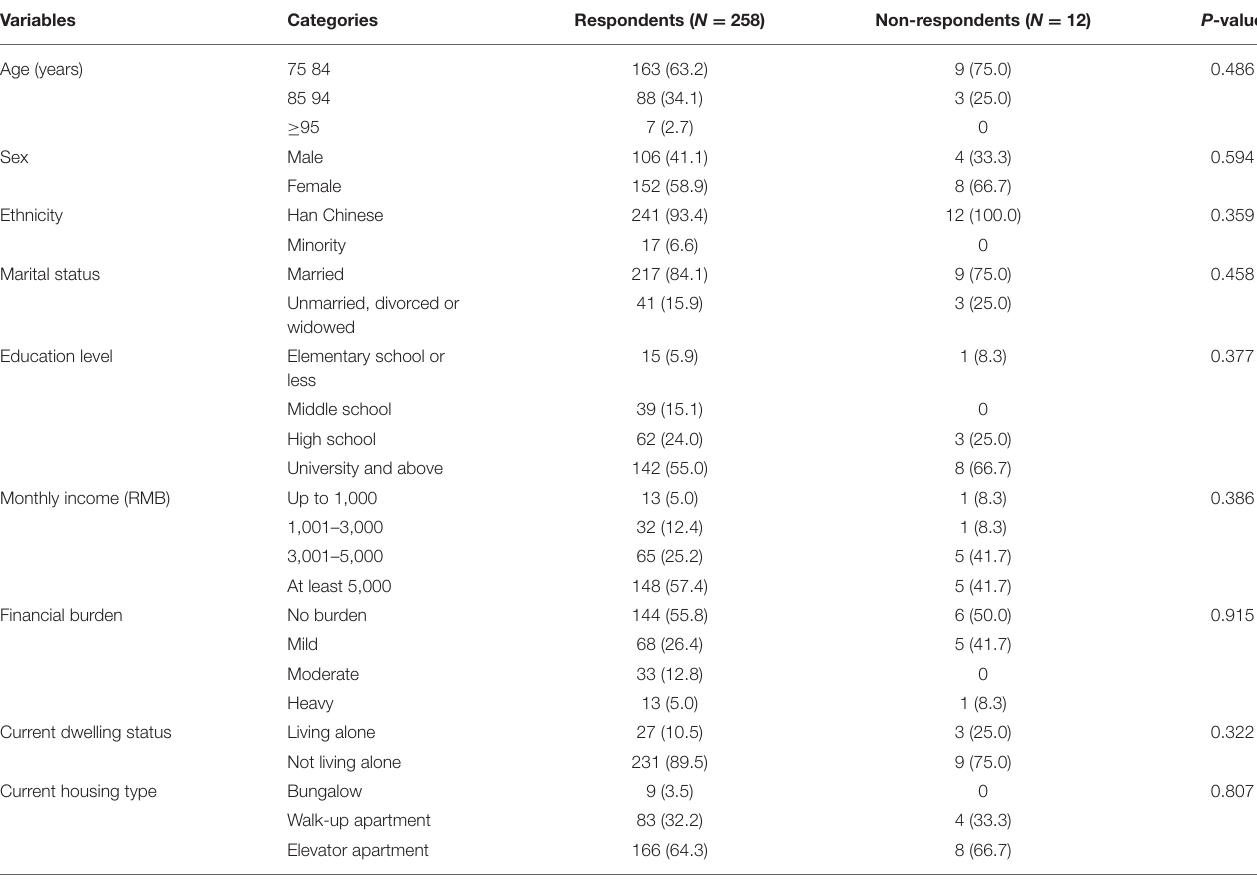
TABLE 1 | Demographics of the study sample.